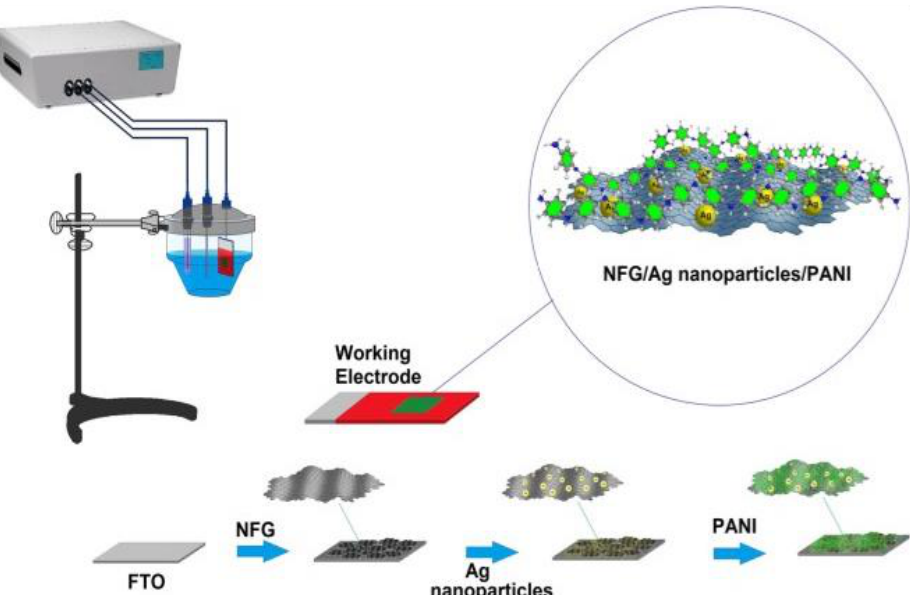
Figure 14. Representation of the synthesis of metal nanoparticles (NPs)-grafted N-doped functionalized graphene